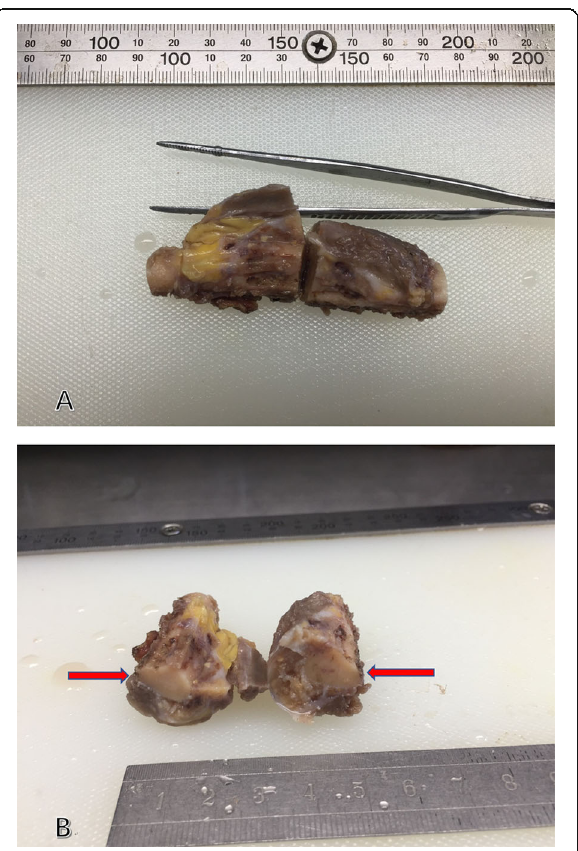
Fig. 6 The resected specimen of the right forearm. a It was located beneath the dermis and could not be separated from the bone. b The size of the mass was 3.5 cm × 2